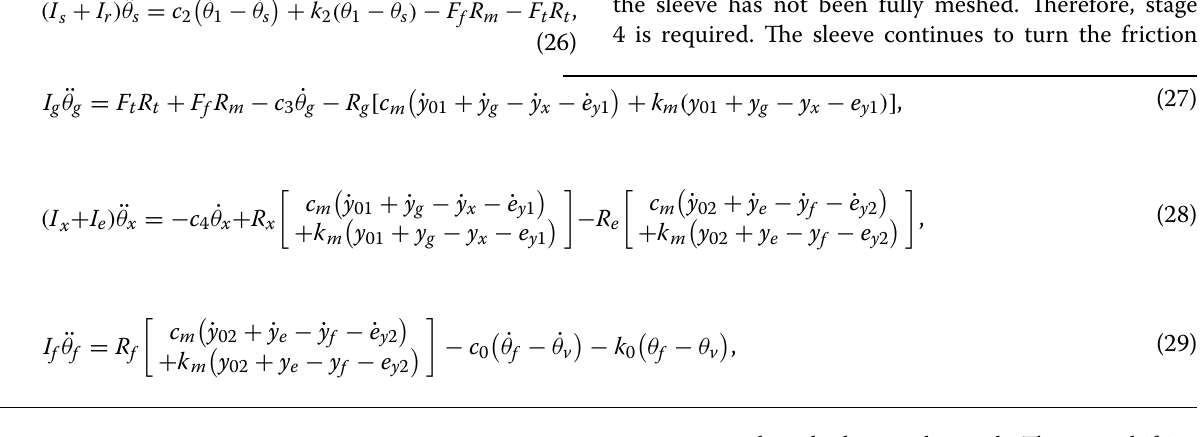
where F t is the tangential component of the turn-teeth force. F N is the positive pressure on the bevel. R t is the turn-teeth radius. γ is the teeth surface angle. Stage 4 : After the speed is eliminated, the sleeve teeth moves in contact with the friction cone ring teeth. The state of PCFRS at this stage is shown in Figure 16. This situation exists when the speed difference between the sleeve and the friction cone ring is eliminated, but